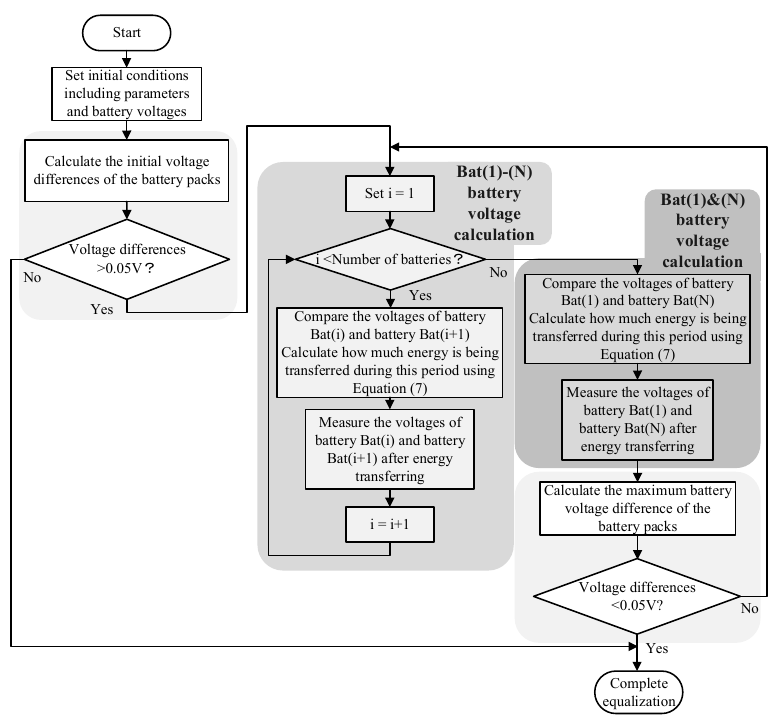
Figure 13. Flowchart of the chain structure of SC-based BE type I.